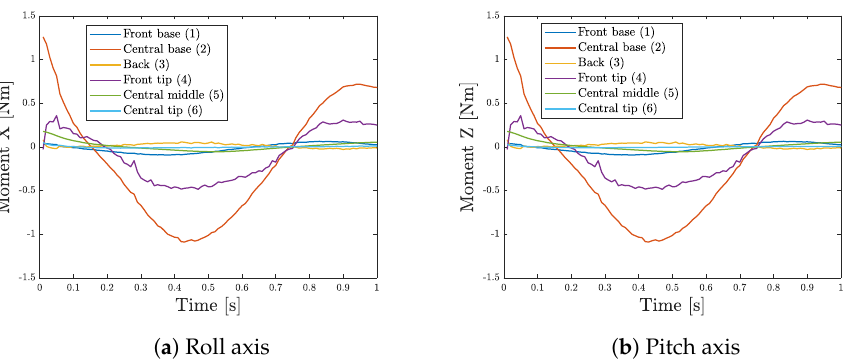
Figure 16. Moments acting on each mechanism.